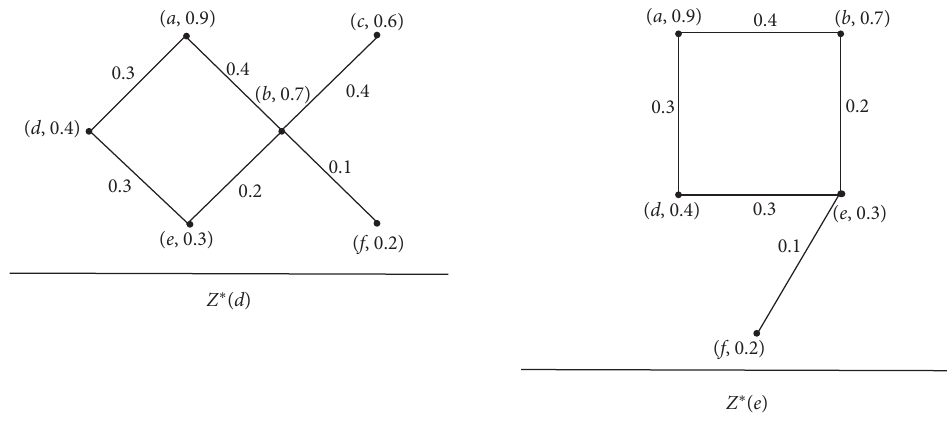
Figure 29: Resultant VN-fuzzy graphs Z ∗ ( e ) and Z ∗ ( d ) .